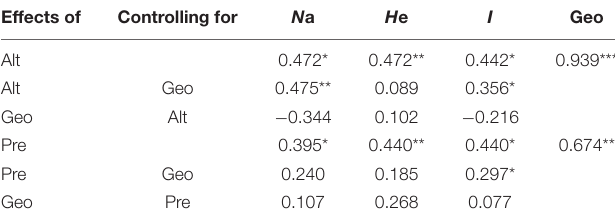
TABLE 3 | Mantel and partial Mantel tests for the correlation between genetic diversity parameter (Bray–Curtis distance) and explanatory distances (geographic and environmental (altitude or precipitation) distance) using Spearman’s